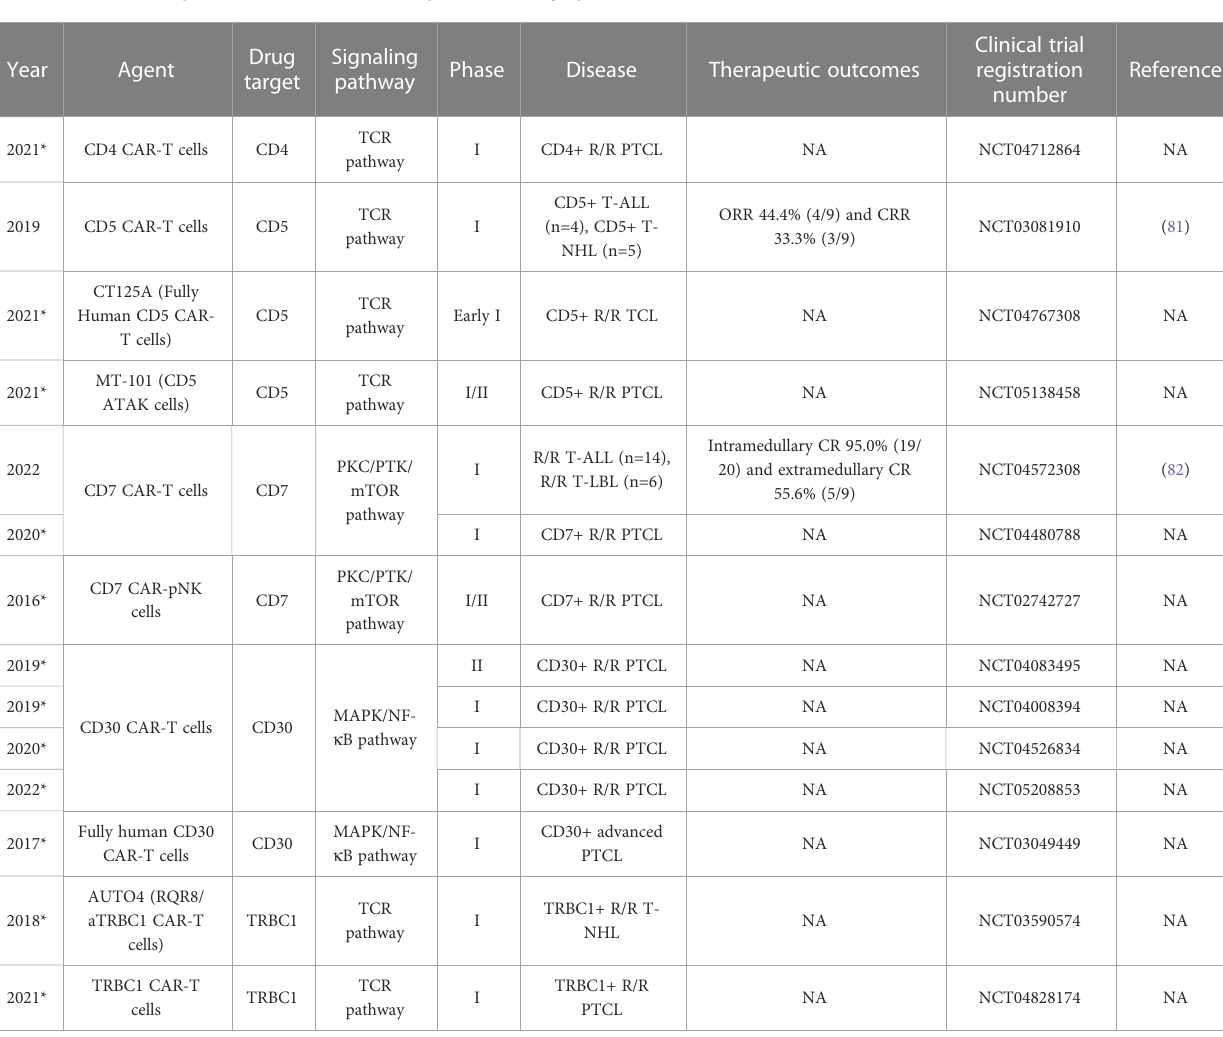
TABLE 5 Novel and experimental CAR immunotherapies for T-cell lymphoma.